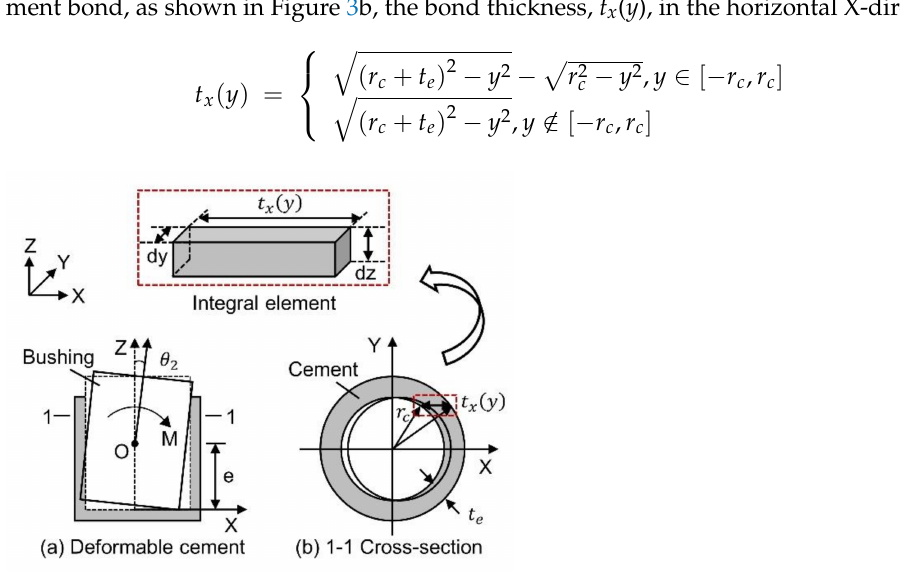
Figure 3. Deformation of the cement